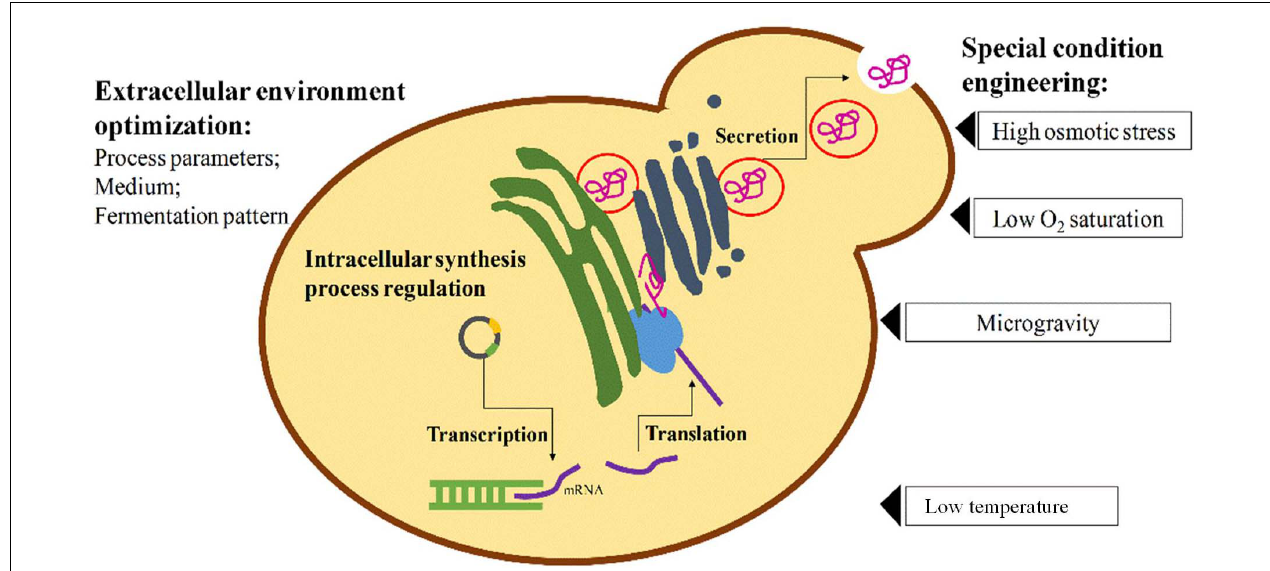
FIGURE 1 | General intracellular and extracellular engineering strategies for enhancing heterologous protein expression in yeasts.